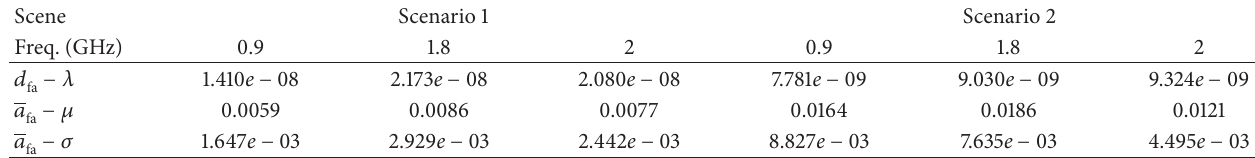
Table 2: Distribution parameters of the excess delay and the normalized amplitude of the first arrival. Scene